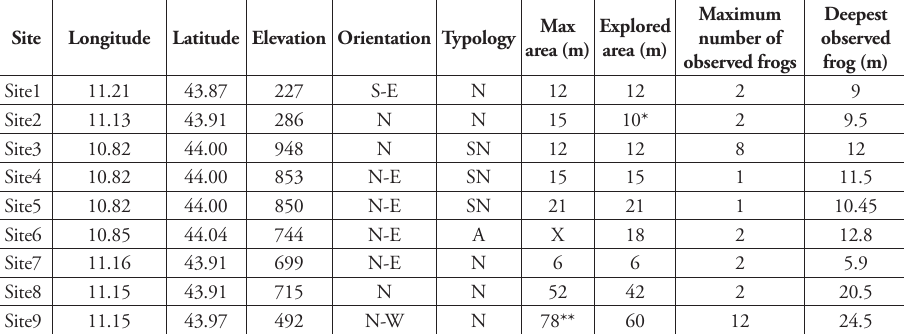
Table 1. Data of explored subterranean environments. For each site are shown: longitude, latitude and elevation, orientation of the main entrance, typology (natural (N), semi-natural (SN), artificial (A)), to- tal development of the inner environment (Max area) and length explored in this study (linear meters), maximum number of observed frogs during a single survey, deepest observed frog (linear distance from cave entrance). *The length of last cave sector was only 1 m as a syphon blocked the passage. **This is a provisional data as the cave is still interested by speleological exploration. "X" means that for the artificial site no information is available for its total